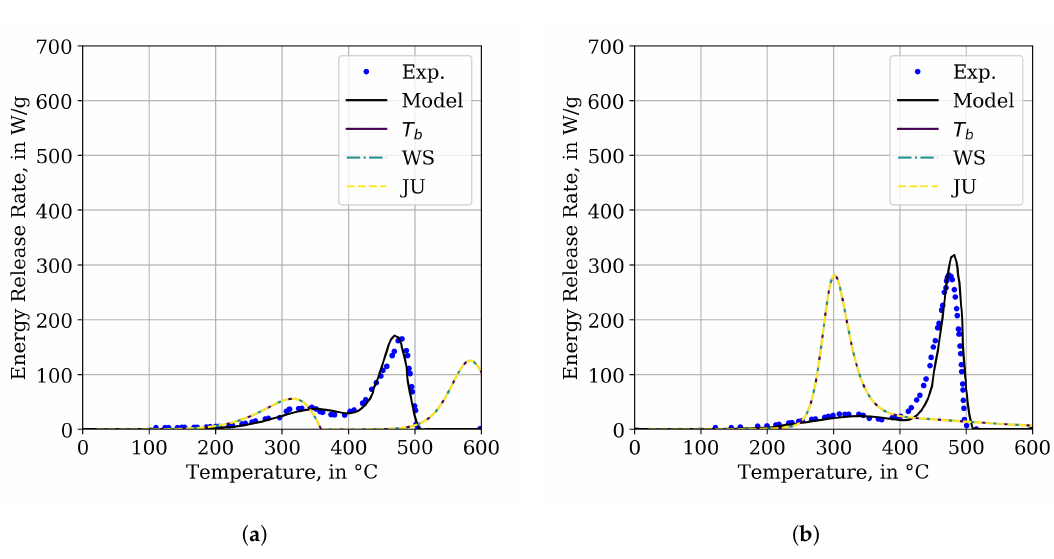
Figure A12. Comparison between energy release rates of MCC simulation of the best parameter set of IMP T b ( TGA_ANALYSIS=.TRUE. ). T b : JURECA, Linux, FDS 6.5.3; WS: Workstation, Windows 10, FDS 6.5.3; JU: JURECA, Linux, FDS 6.7.0. ( a ) MCC simulation response of the jacket material. ( b ) MCC simulation response of the insulator material.